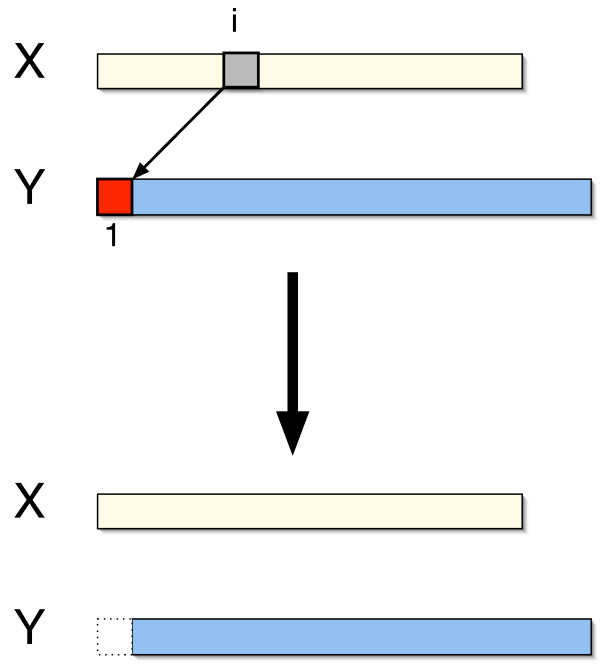
Recurrence: Case 1. y1 is generated from xi in a duplicate operation where y1 is the last (rightmost) character in the copied substring (Case 1). The total duplication distance is one plus the duplication distance for the suffix y2,|y|.